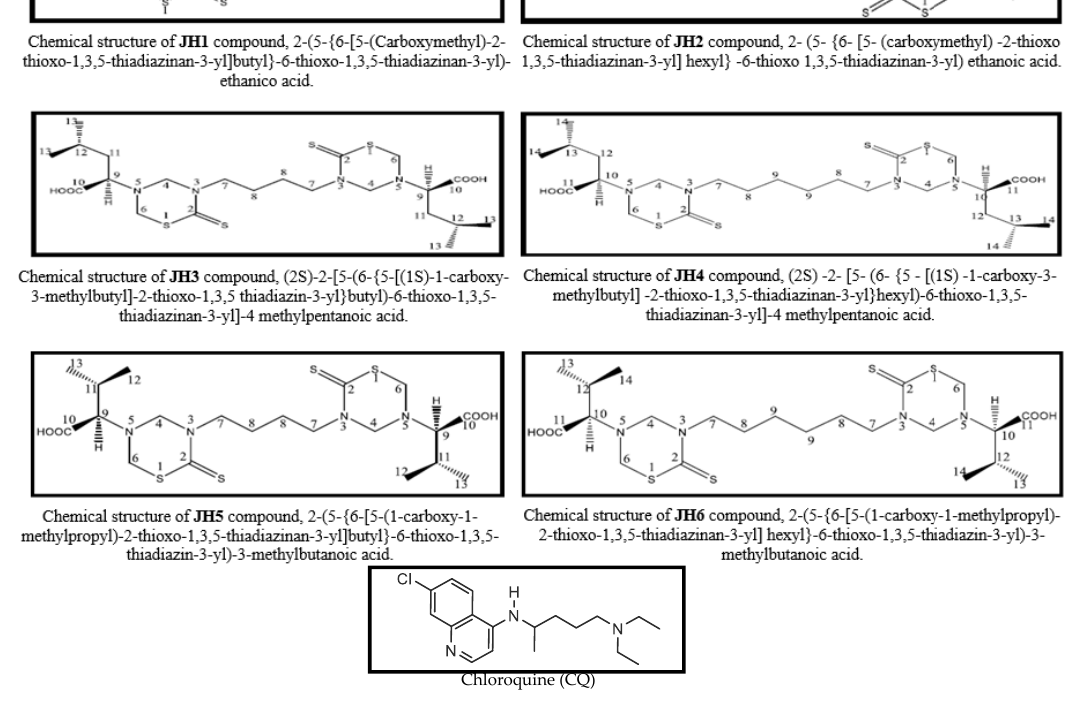
Figure 1. Chemical structure of bis-THTT (JH-1 to JH-6), and for Chloroquine (CQ).